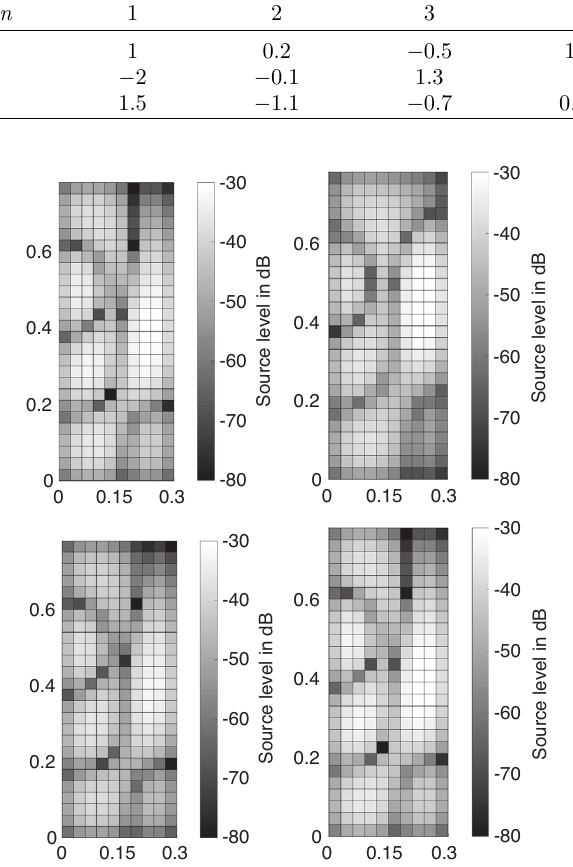
Figure 21. Comparison of the original pattern at 100 Hz (left upper corner) with the reconstructed pattern for 12 receiving position (right upper corner), 48 receiving position (left lower corner) and 64 receiving positions (right lower corner).